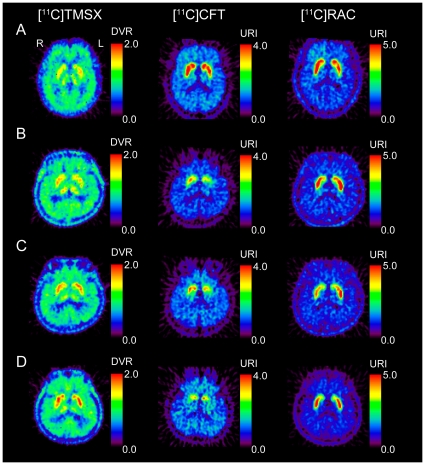
PET images for normal subjects, a drug-naïve patient with Parkinson's disease (PD), and a PD patient with dyskinesia.The normal subjects are a 63-year-old female for [11C]TMSX, and a 63-year-old male for [11C]CFT and [11C]RAC (A). The drug-naïve patient is a 60-year-old male with right-dominant parkinsonism, and underwent two series of PET scans before (B) and after anti-parkinsonian therapy (C). The patients did not developed dyskinesia at a second series of PET scan in the post-therapeutic state. The DVR of [11C]TMSX was smaller in the left putamen than in the right and was increased after treatment with anti-parkinsonian therapy for 14 months. The uptake of [11C]CFT was reduced in the putamen, especially on the left. The uptake of [11C]RAC was preserved in the striatum and was larger in the left putamen than in the right. The relative uptake of [11C]CFT and [11C]RAC in the putamen was lower in the post-therapeutic state than in the drug-naïve state. The PD patient with dyskinesia is a 65-year-old male with right-dominant parkinsonism (D). His disease duration was 19 years. The DVR of [11C]TMSX was increased in the striata. The uptake of [11C]CFT was significantly decreased in the putamen.